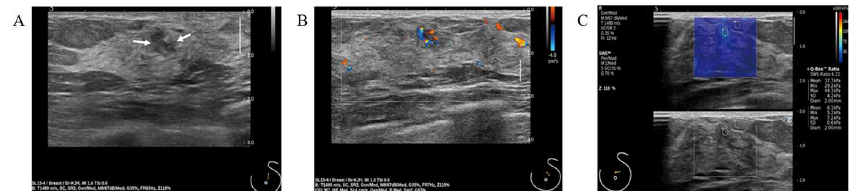
Fig 3. Benign intraductal papilloma diagnosed at ultrasound-guided core needle biopsy. (A-C) (A) B- mode ultrasoundshows an irregularshapedhypoechoic mass (1 cm, arrows). (B) Color Dopplershowing increasedvascularity in the mass. This mass was assessed as category 4B. (C) Shear-waveelastography image showinga light blue color (Emax, 44.1 kPa). This mass was finally surgically excised and proved as benignintraductal